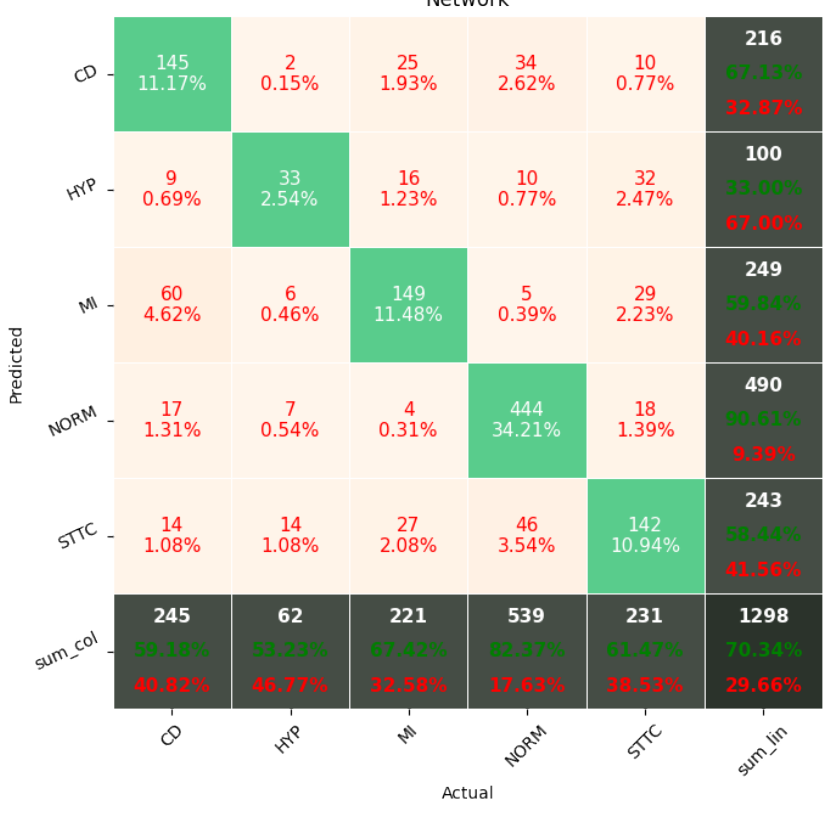
Figure 10. Confusion Matrix for Few-Shot (5 classes) with proximity-based